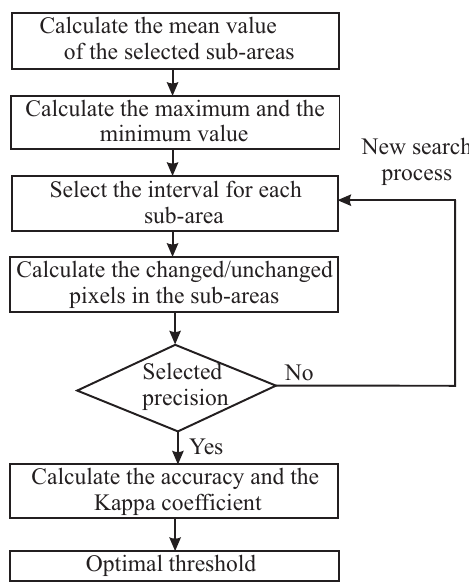
Figure 4: Flowchart of the proposed threshold determination al- gorithm.